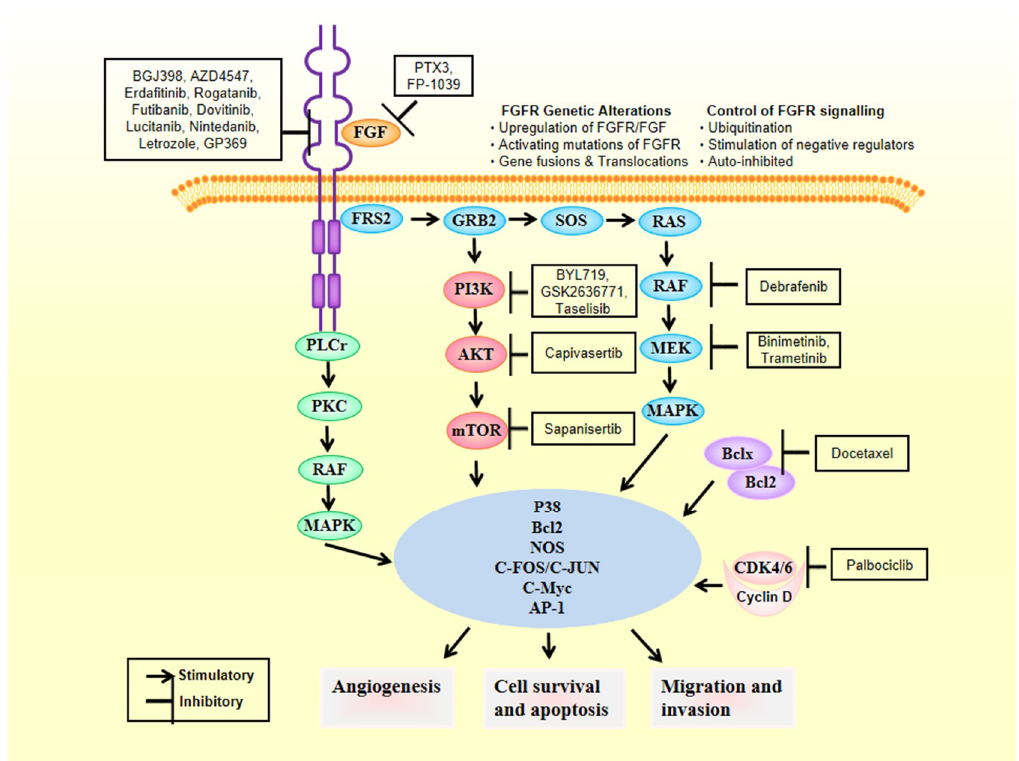
Figure 1. Therapies fighting breast cancer through the fibroblast growth factor receptor (FGFR) pathway.